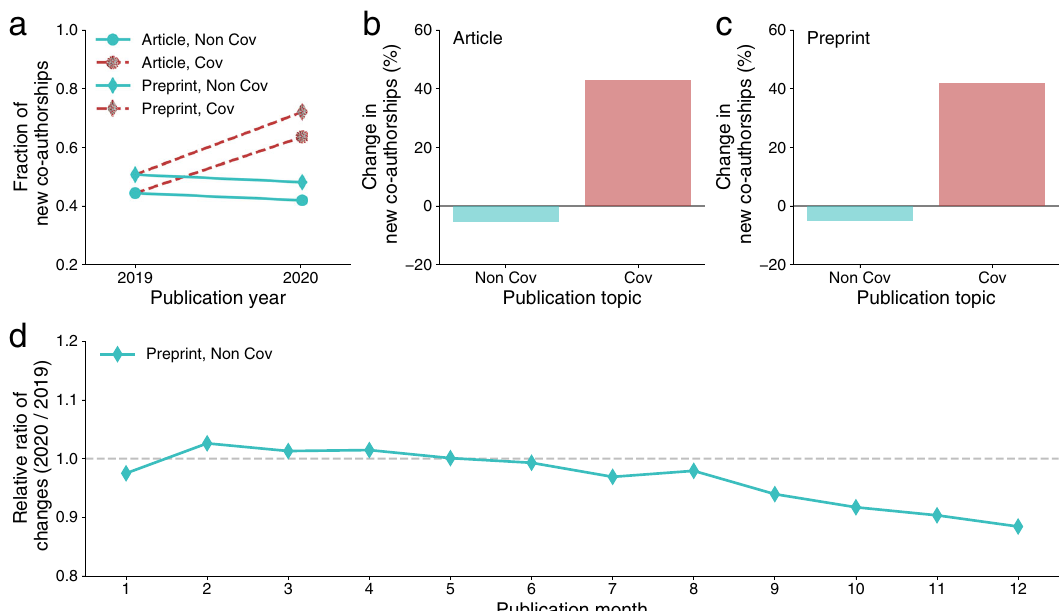
Fig. 2 Changes in new co-authorships measured by large-scale publication datasets. a The fraction of new co-authorship pairs in the author list of COVID-19 and non-COVID-19 papers published as articles or preprints in 2019 and 2020. b The average change in the fraction of new co-authorships measured for articles in 2020 comparing with that in 2019. c The average change in the fraction of new co-authorships measured for preprints in 2020 comparing with that in 2019. d The relative ratio of the fraction of new co-authorships in 2020 over the fraction in 2019 measured for non-COVID-19 preprints published in each month of the